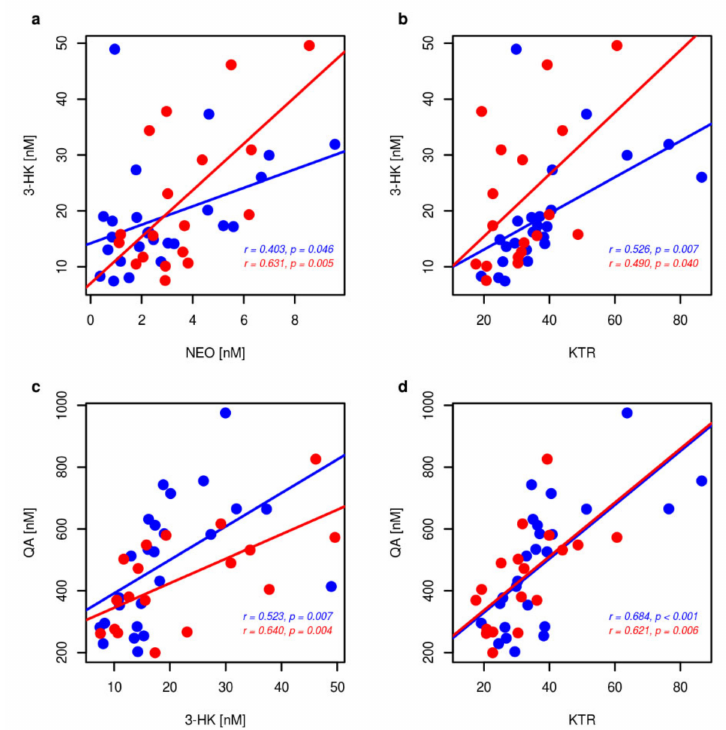
Figure A2. Graphs of ( a ) 3-HK correlation with inflammatory marker NEO, ( b ) 3-HK correlation with inflammatory marker KTR, and ( c ) 3-HK correlation with QA in plasma of patients with SCAS (blue color) and AIS (red color). ( d ) Correlation of QA with KTR in plasma of patients with SCAS and AIS. Abbreviations: 3-HK: 3-hydroxykynurenine; QA: quinolinic acid; KTR: 1000 × [KYN] /